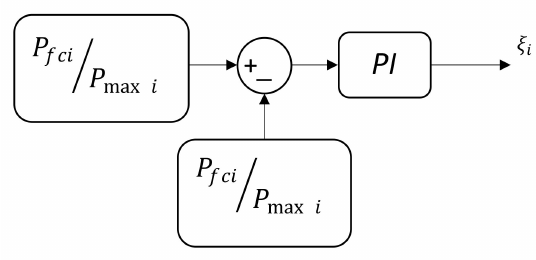
Figure 9. Centralized secondary control